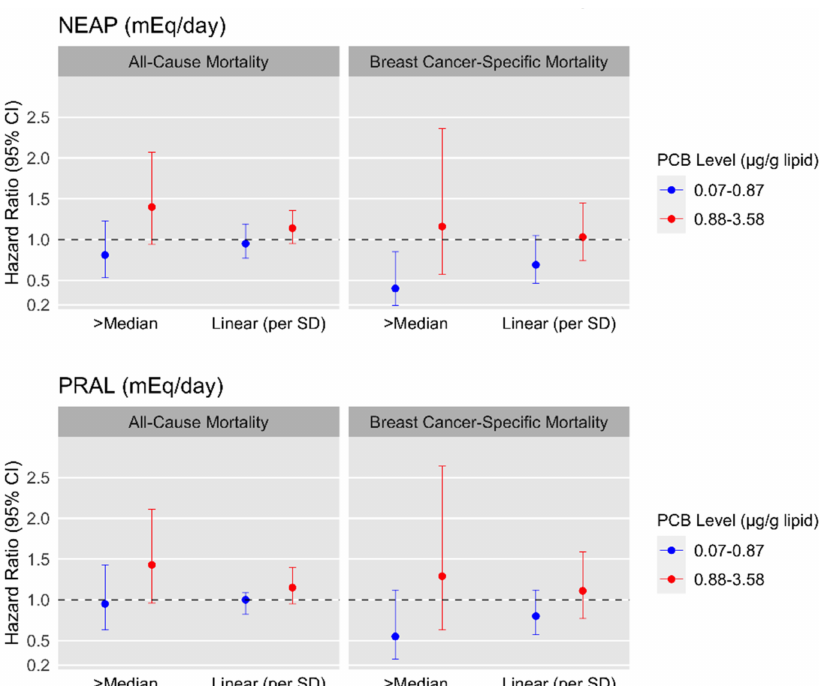
Figure 1. Forest plot of hazard ratios (HRs) and 95% confidence intervals (CIs) for the fully adjusted associations between dietary acid load scores and all-cause and breast cancer-specific mortality by serum total lipid-adjusted PCB levels ( n = 591). Model is adjusted for age at diagnosis (continuous